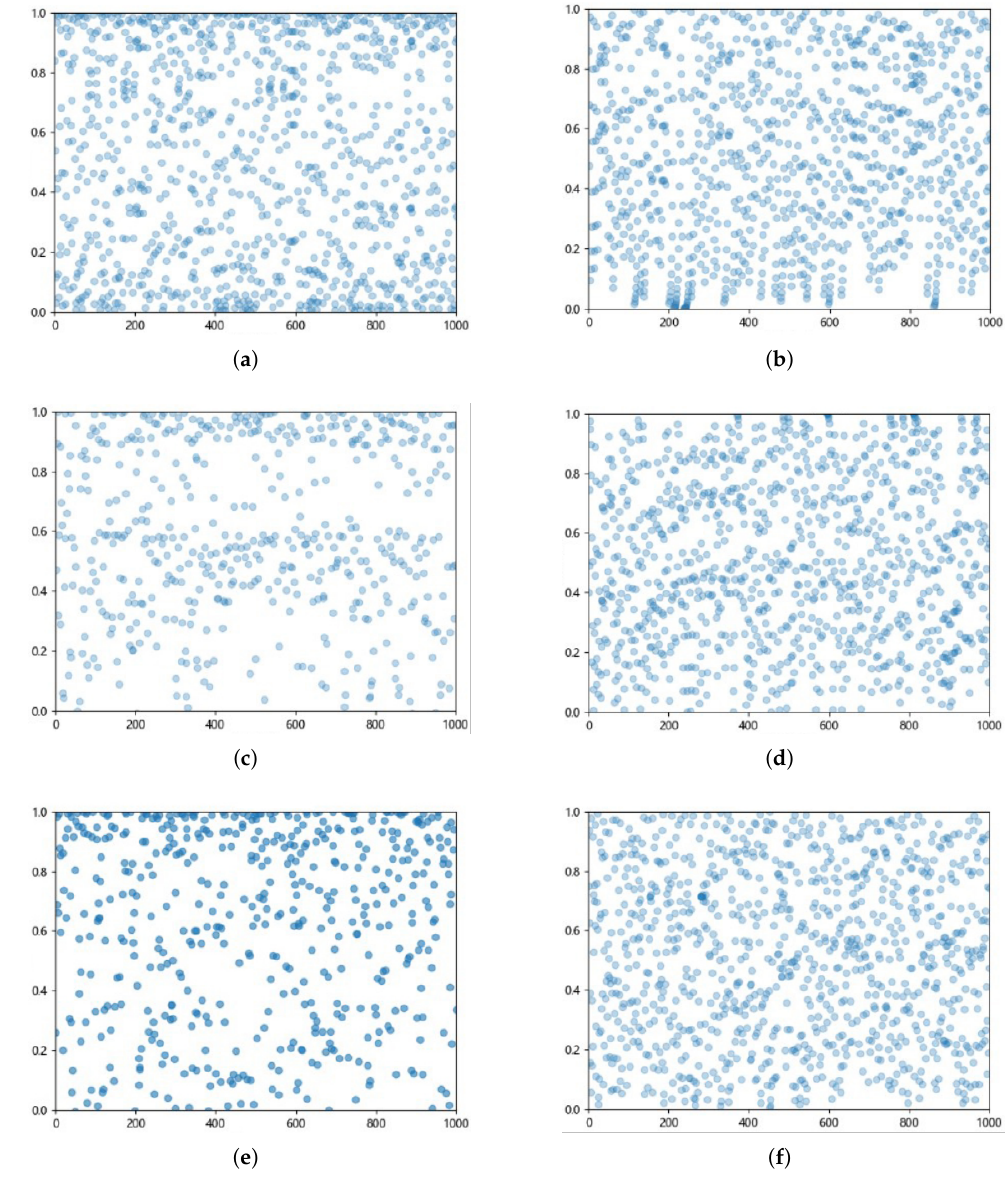
Figure 1. The distribution of 1000 iterations of six chaotic mappings, ( a ) logistic mapping, ( b ) tent mapping, ( c ) iterative mapping, ( d ) intermittency mapping, ( e ) chebyshev mapping, and ( f ) piecewise